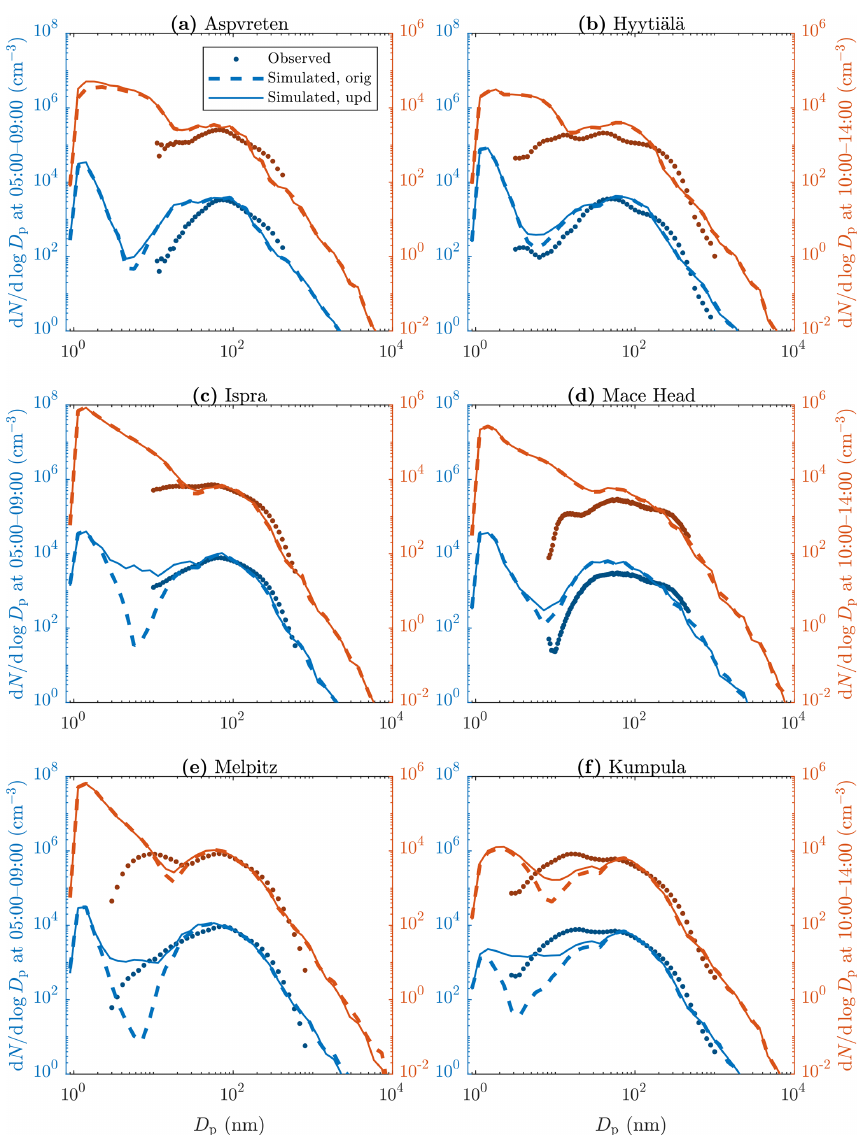
Figure 6. Monthly means of PSDs at selected measurement stations (a–f) from observations (markers) and from simulations using the original (dashed lines) and the updated (solid lines) emission inventory in the mornings (blue) and in the daytime (red). All times represent local times. Note different axis limits for morning and daytime